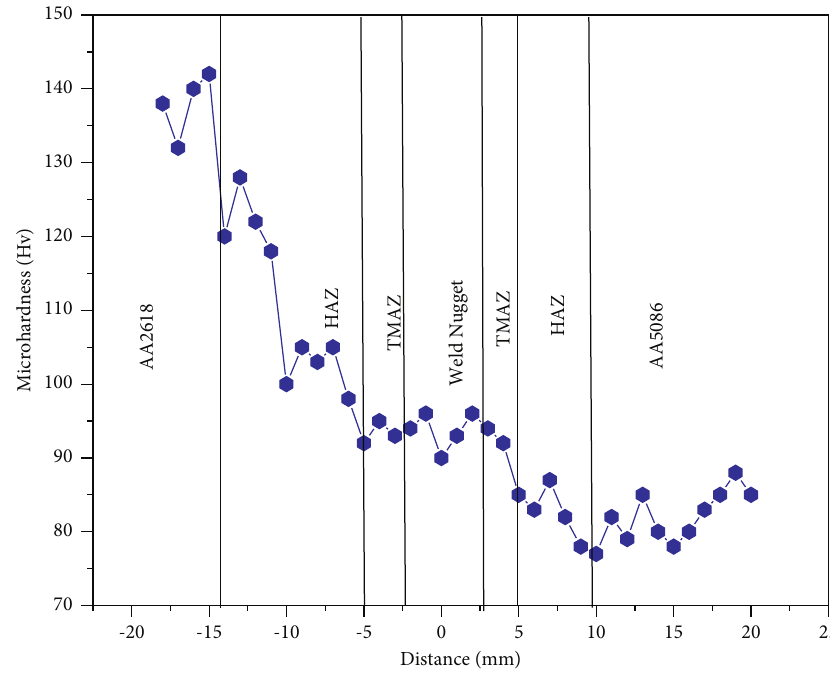
Figure 6: Welding microhardness